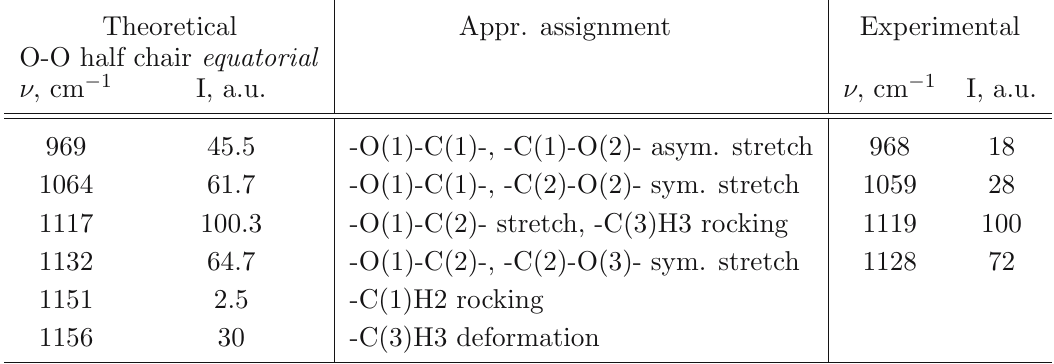
“a.u.” means arbitrary